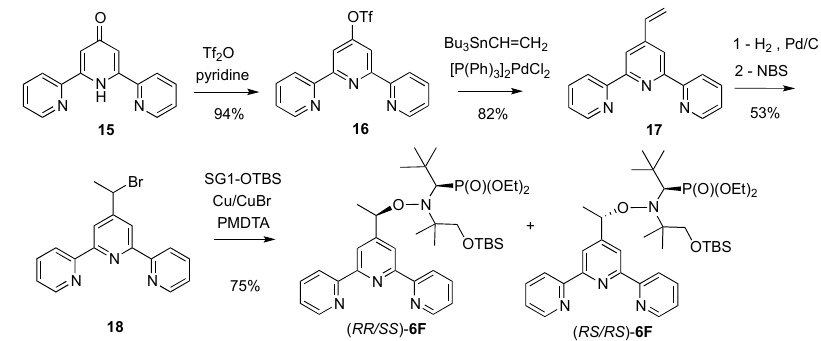
Scheme 1. Synthesis of alkoxyamines (RR/SS)- 6F and ( RS / SR )- 6F .